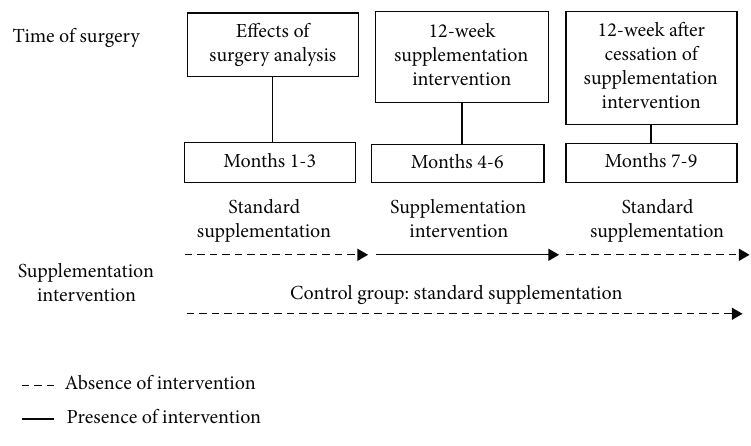
Figure 2: Supplementation intervention study design in BS